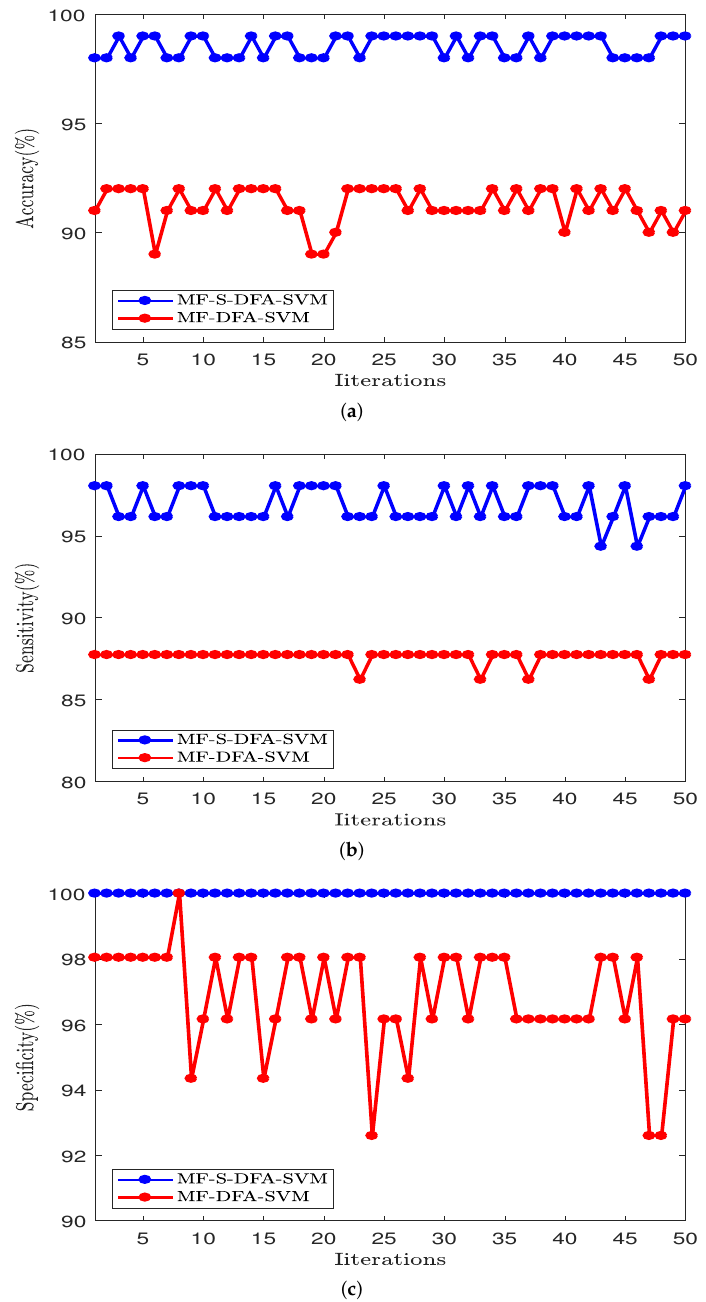
Figure 12. Classification evaluation index: ( a ) accuracy, ( b ) sensitivity and ( c ) specificity. A color version of the figure is available in the web version of the